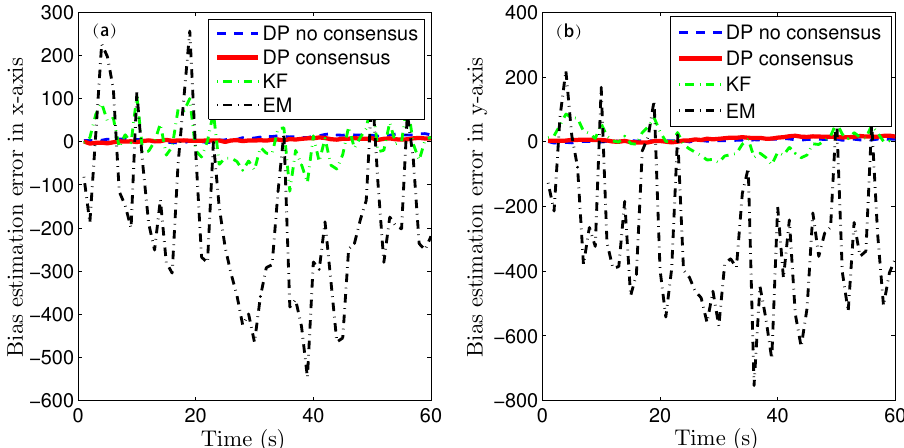
Figure 16. Bias estimation errors using the KF, DP consensus, DP no consensus and EM methods for sensor 4 in the multi-sensor system of 60 sensors. ( a ) x-axis; ( b )